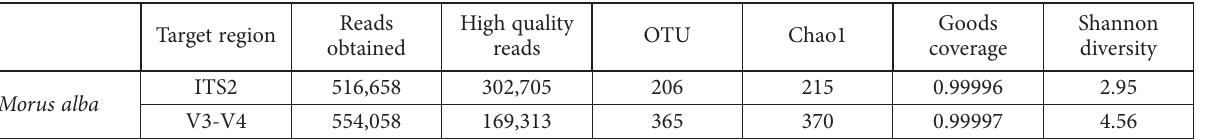
Table 2. List and relative abundance of bacterial and